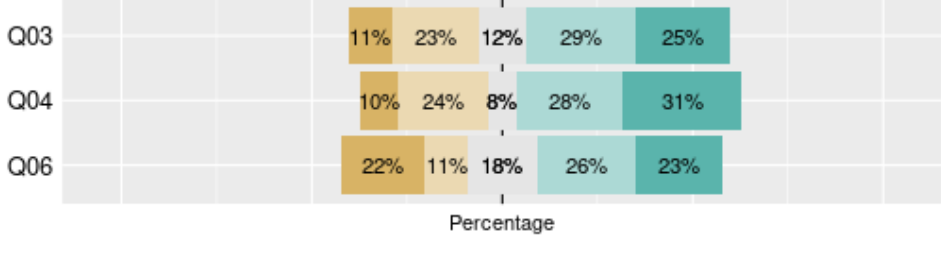
Figure 2. Processing of personal